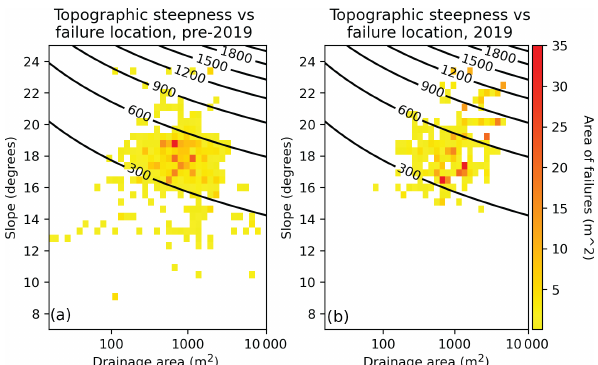
Figure 6. Mapped failures (a) before and (b) after the August 2019 rainstorm and survey plotted in slope–area space with con- tours demonstrating topographic steepness (the product of slope and the square root of drainage area). Colors demonstrate areal extent of failures that fall into each slope–area bin versus the entire area rep- resented by the UAS survey